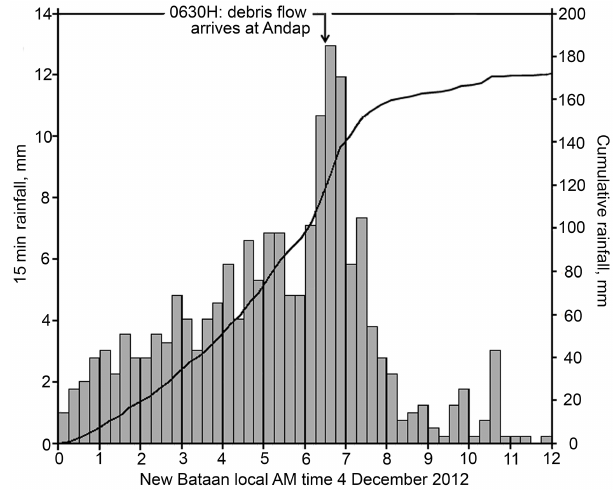
Figure 5. The rainfall that triggered and sustained the debris flows. Histogram measures rain accumulated during successive 15min in- tervals; the heavy curve is accumulated rainfall. logic knowledge would prove fatal during Super Typhoon Bopha (Fig.